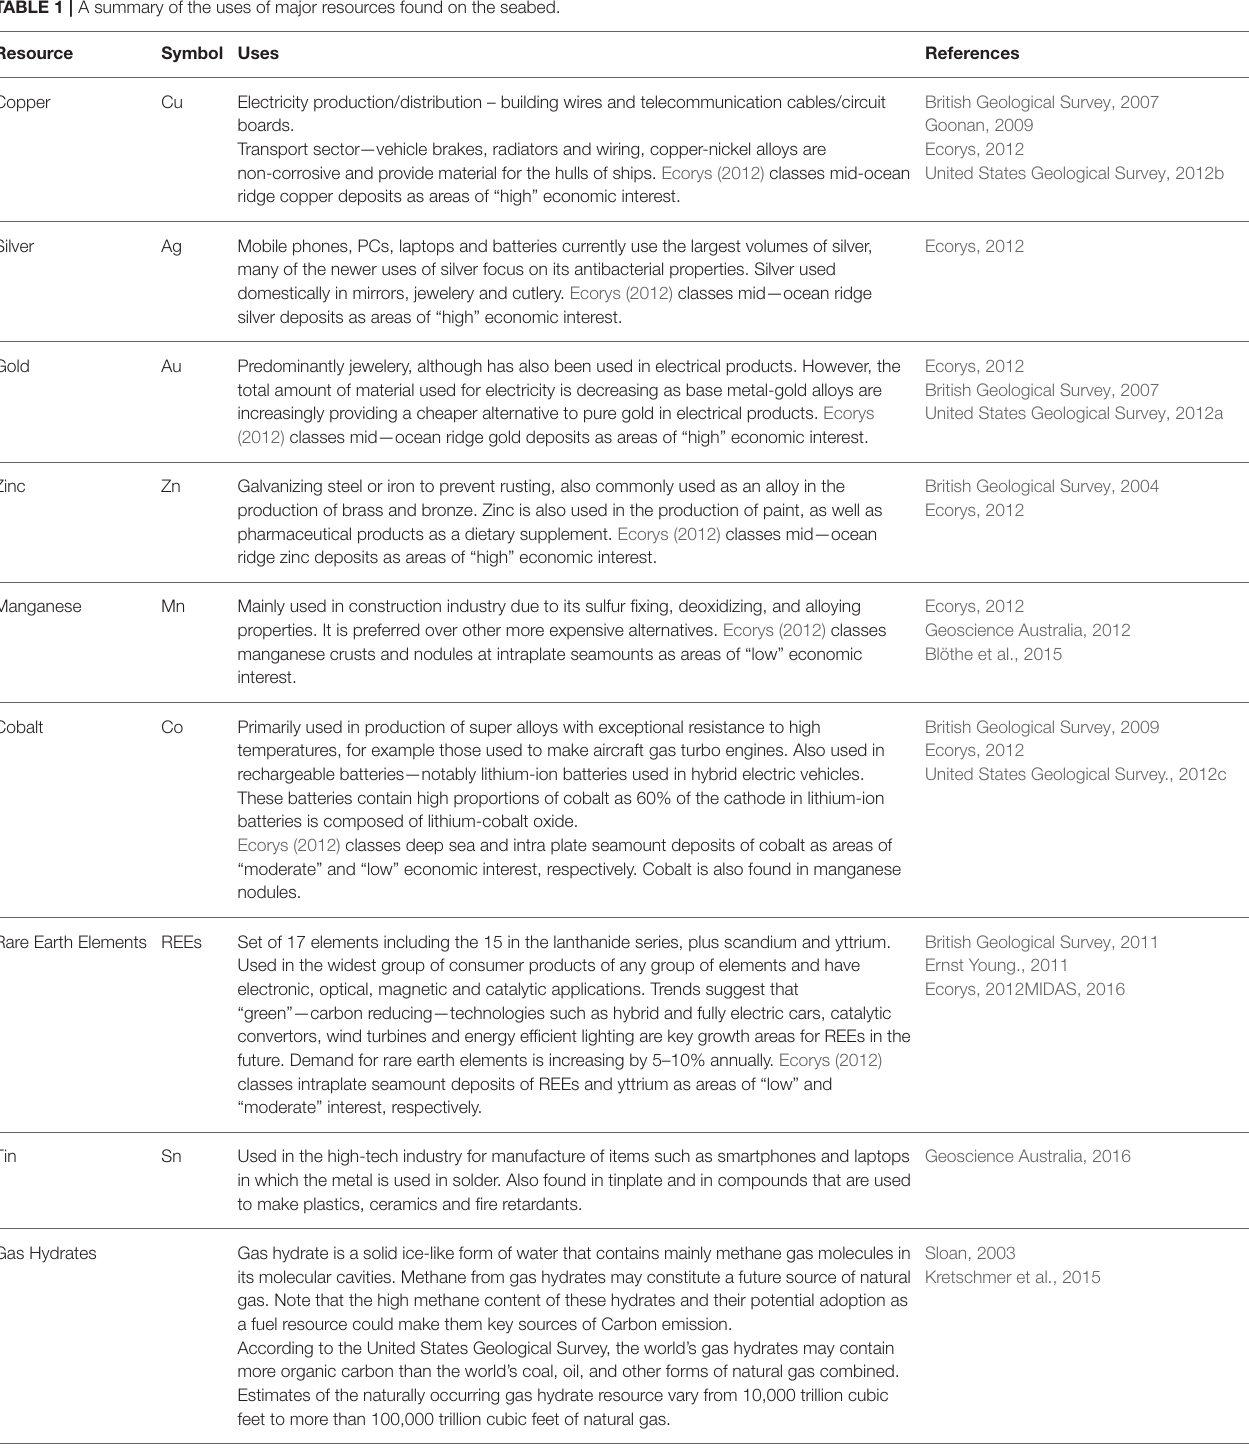
TABLE 1 | A summary of the uses of major resources found on the seabed.